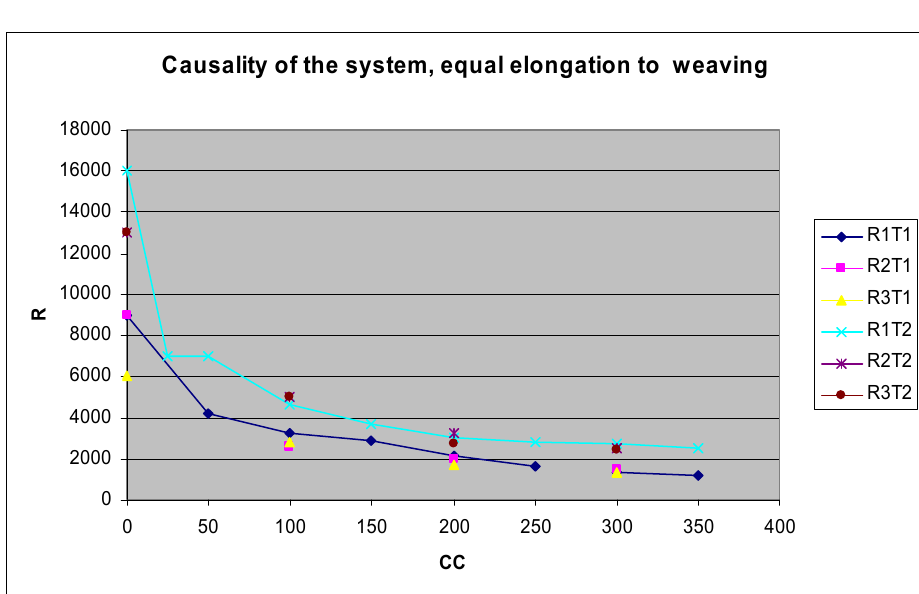
Figure 9. Graphic of the sixth test